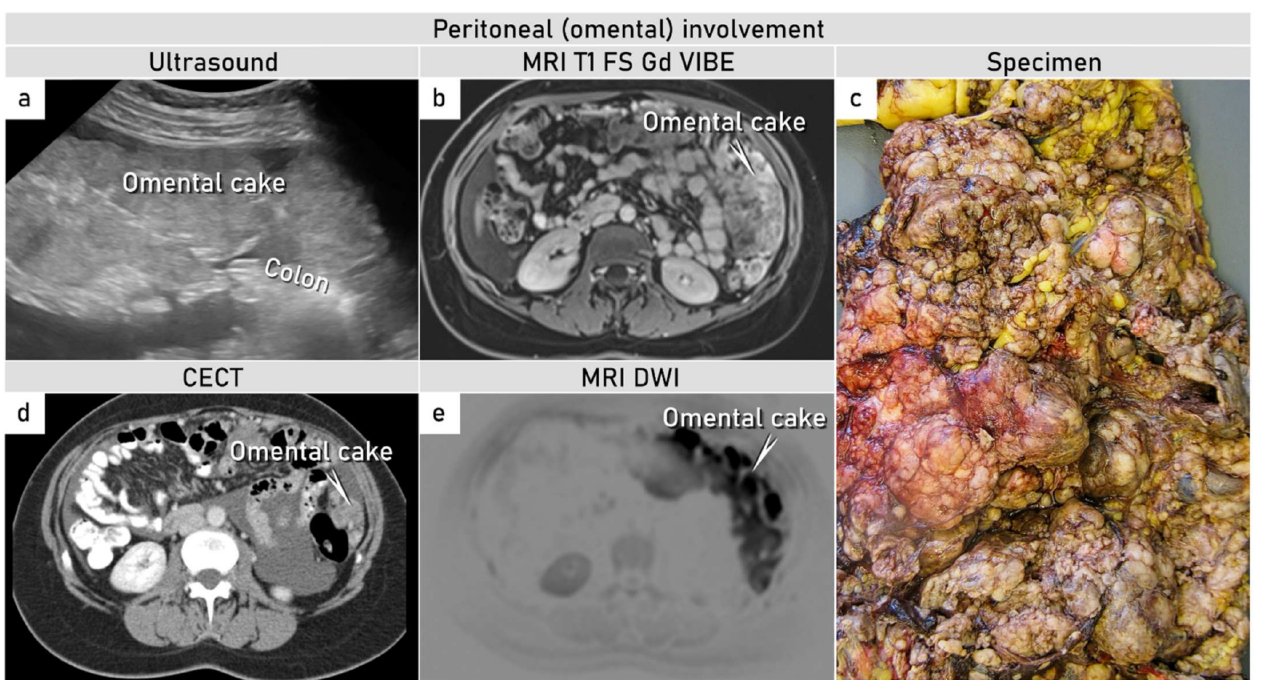
Figure 4. Omental tumor. ( a – e ) Ultrasound, magnetic resonance with diffusion-weighted images, contrast-enhanced computed tomography, and specimen demonstrating omental tumor (images in transverse plane). ( a – e ) Omental cake. Abbreviations: MRI T1 FS Gd VIBE, T1-weighted mag- netic resonance imaging after intravenous gadolinium; VIBE, volumetric interpolated breath-hold examination; CECT, contrast-enhanced computed tomography; DWI, diffusion-weighted